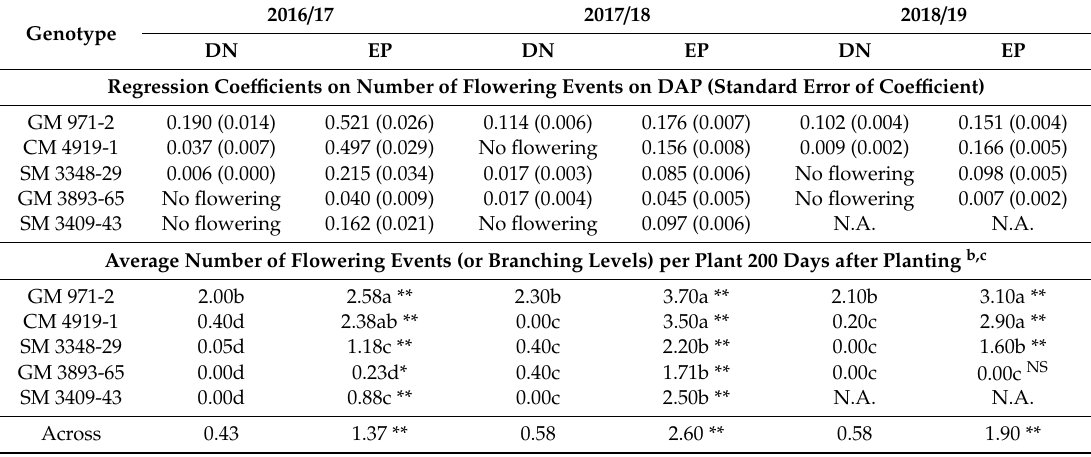
Regression Coefficients on Number of Flowering Events on DAP (Standard Error of